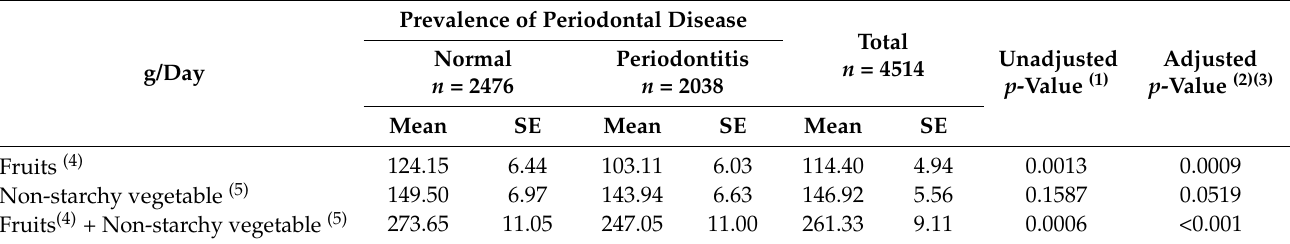
Table 6. Plant food intake according to prevalence of periodontitis in survey